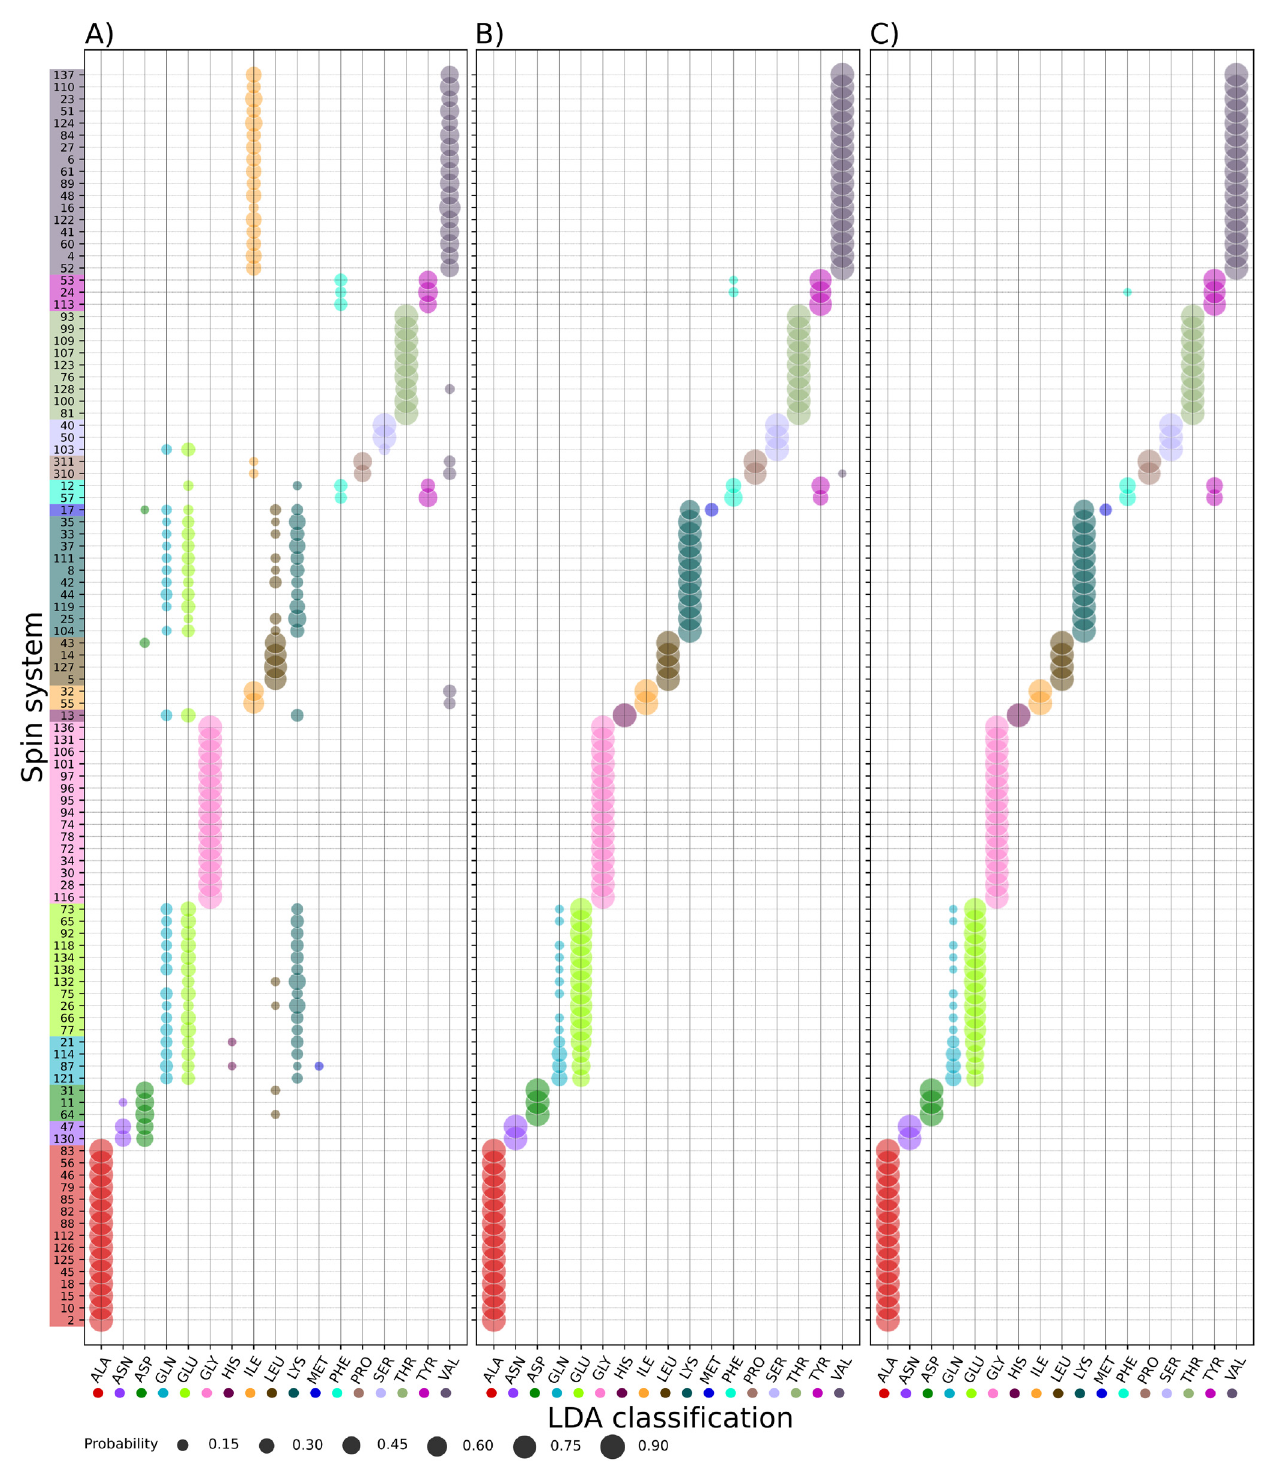
Fig 7. Results of LDA of the chemical shifts of α -synuclein: A) subset (i) (H N , N, CO and C α ); B) subset (ii) (C α , C β H α and H β ); and C) subset (iii) (H N , N, CO, C α , C β , H α and H β ). The vertical axis shows the spin system numbers, the horizontal axis the amino acid types (LDA classes). Spin system numbers are colored according to their true amino acid type. Marker sizes indicate the probability, according to LDA, that the spin system in question belongs to a given